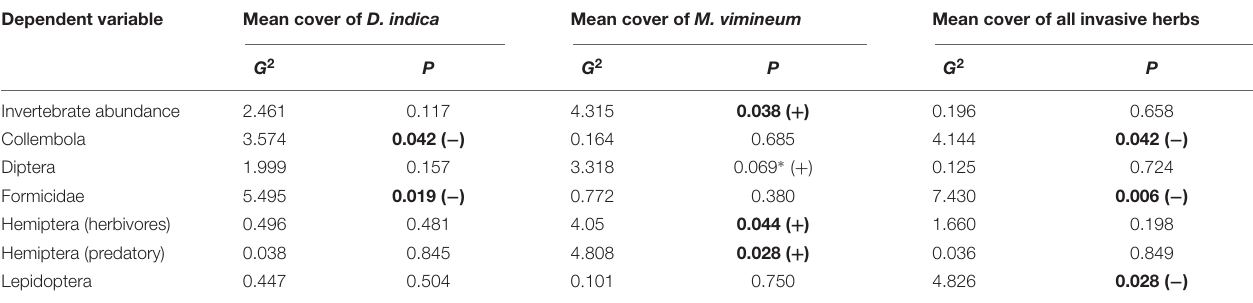
TABLE 3 | Correlations between selected insect groups and invasive plant covariates. Dependent variable Mean cover of D. indica Mean cover of M. vimineum